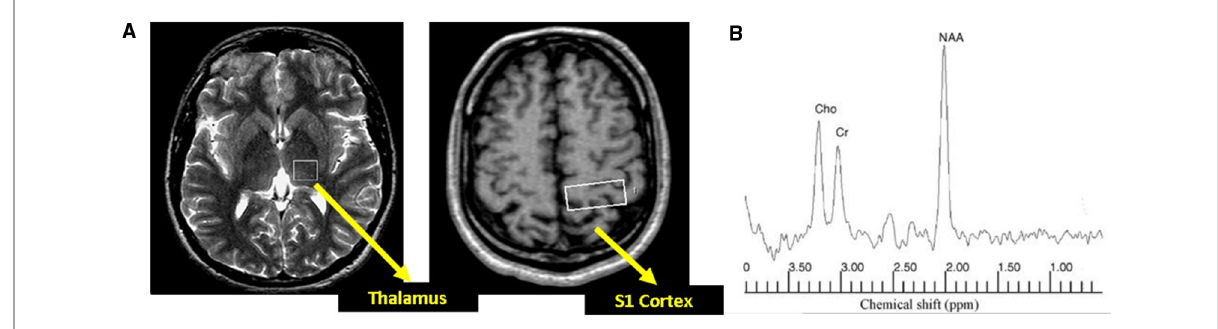
FIGURE 1 ( A ) Axial section of the brain with voxel positioning in the thalamus and primary somatosenxory (S1) cortex. ( B ) Example of spectra obtained using a point-resolved acquisition technique. NAA, N-acetyl aspartate; Cho, choline; Cr,